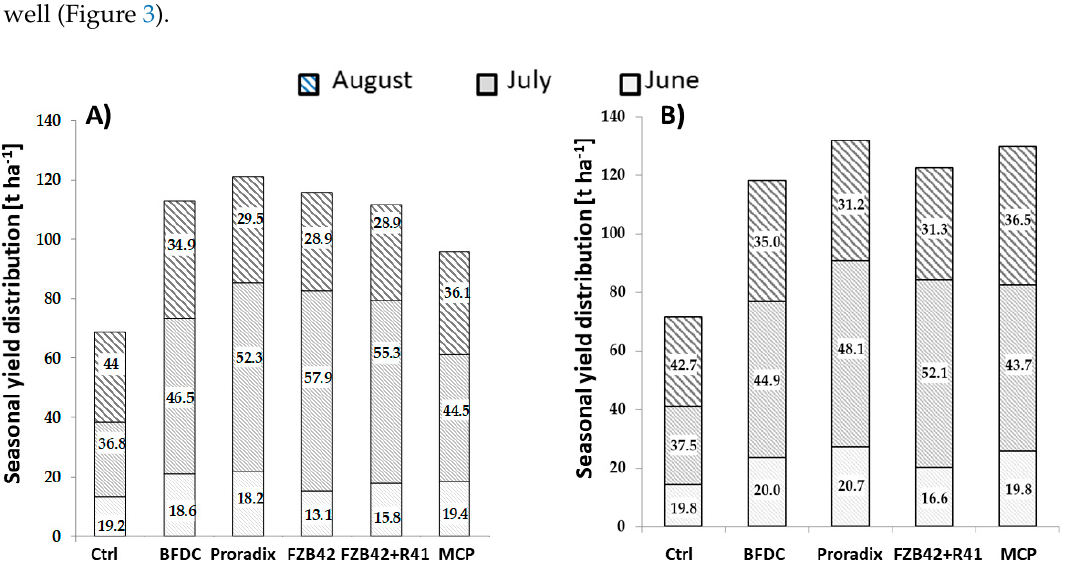
Figure 2. Cumulative yield (t ha − 1 ) and fruit size distribution (t ha − 1 and %) for greenhouse tomato production with different BS treatments in 2016 (A) and 2017 (B). Quality classes (g FW fruit − 1 ): extra- large: >200 g, class I: 150–200 g, and class II: <150 g. Columns represent mean values of cumulative fruit yield ± SD ( n = 4). Significant treatment differences in cumulative yield (Tukey test, p ≤ 0.05) are indicated by different characters.